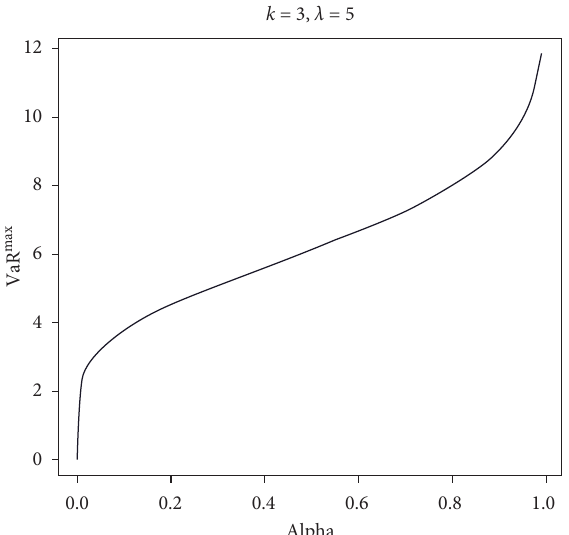
� 20, θ � 5, θ � 6, θ � 7 , θ � 8, θ � 7 , 5, θ � 8, li 1 2 3 11 12 21